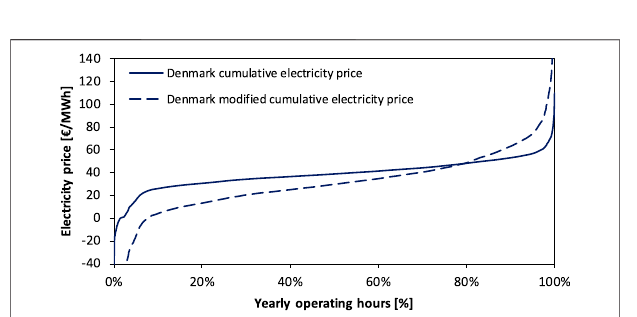
FIGURE 9 | Denmark cumulative electricity price and modi fi ed Denmark cumulative electricity price.